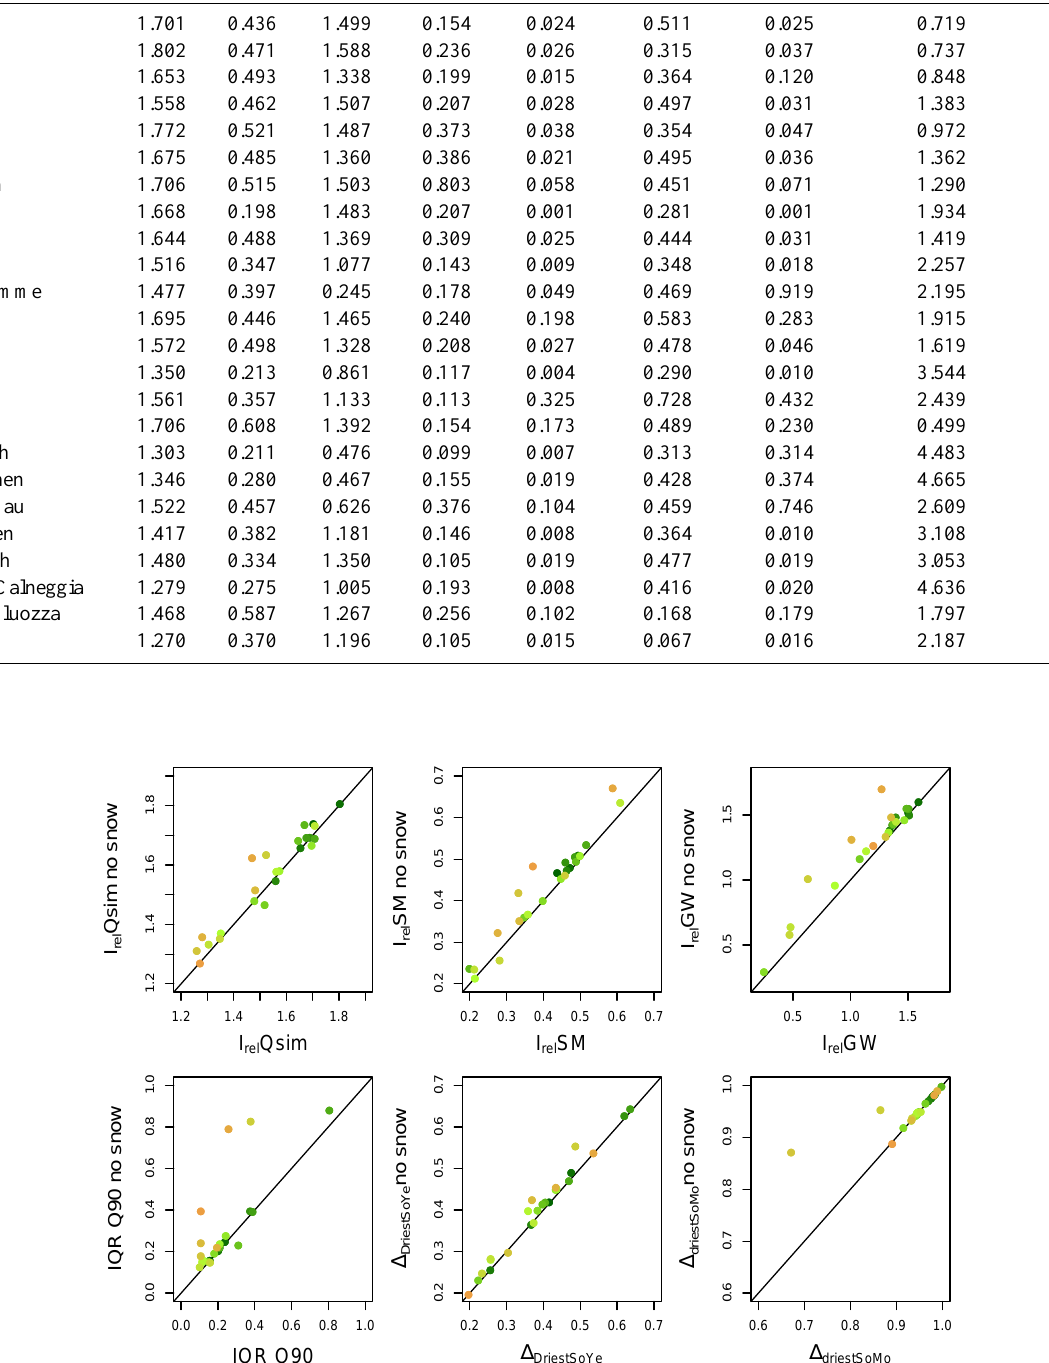
Table 3. Drought indicators for all catchments. The smaller the value the less sensitive the catchment is to drying. I rel SM Catchment I rel Q sim